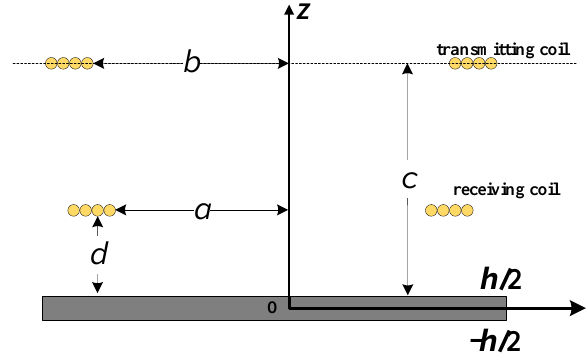
Figure 3. Position relation between two coils and the metal plate.